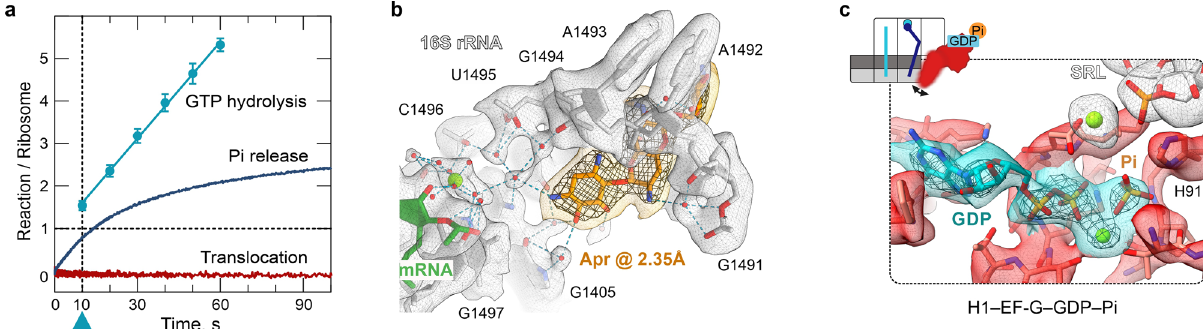
Fig. 2 Timing of complex preparation and high-resolution features. a Rapid kinetics analysis of translocation under cryo-EM conditions (4 °C, with Apr). The blue triangle marks the time point (10 s) of cryo-EM preparation (Methods). GTP hydrolysis: error bars represent the standard deviation of three independent experiments ( N = 3). Pi release: time courses are averages of four technical replicates ( N = 4). Translocation: time courses are averages of eight technical replicates ( N = 8). b High-resolution structure of Apr bound to the SSU decoding center in C state. c GTP-binding pocket of EF-G in the GDP – Pi state. The cryo-EM density at a high threshold (5 σ , wide mesh) shows the Pi as a separate, non-covalently coordinated entity; transparent surfaces, cryo-EM density at a lower threshold (3 σ